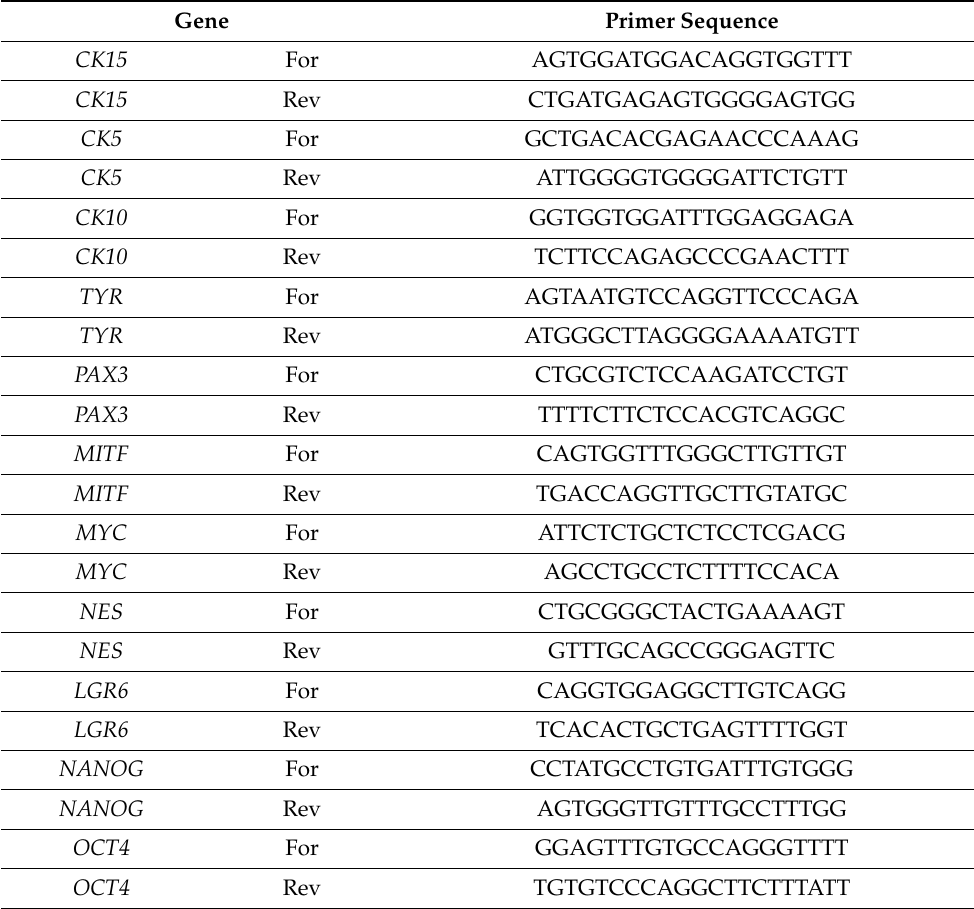
Table 2. Primer sequences for qRT-PCR analysis of marker gene